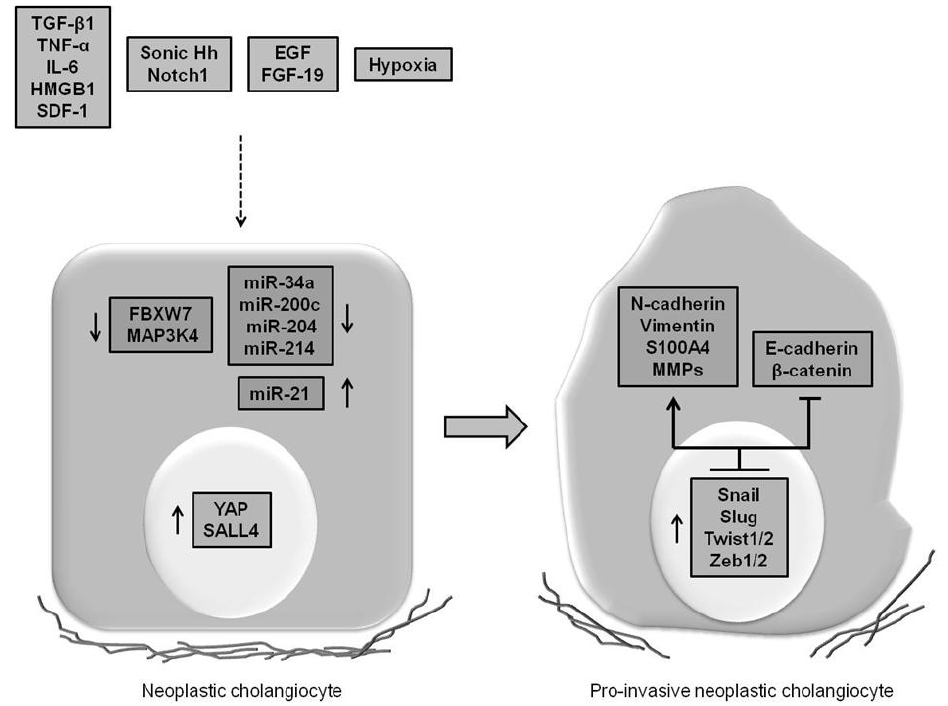
Figure 1. Autocrine and paracrine signals and intracellular stimuli orchestrate the switch towards a “transitional” phenotype during neoplastic transformation. The emergence of mesenchymal traits in CCA cells (up-regulation of N -cadherin, vimentin, S100A4 and metalloproteinases, along with down-regulation of E-cadherin and membranous β -catenin) is driven by a set of embryonic transcription factors (Snail, Slug, Twist1/2, and Zeb1/2), whose expression is induced by both soluble factors released in the tumor microenvironment (cyto/chemokines, growth factors, and morphogens) and mutational events affecting the activity of miRNAs, oncogenes, and tumor suppressor genes. These “transitional” changes allow cancer cells to reduce intercellular adhesion and dismantle the basement membrane, resulting in a motile phenotype. Transforming growth factor β 1, TGF- β 1; tumor necrosis factor α , TNF- α ; interleukin 6, IL-6; high-mobility group box 1, HMGB1; stromal cell-derived factor 1, SDF-1; epidermal growth factor, EGF; fibroblast growth factor 19, FGF-19; Hedgehog, Hh; F-box and WD repeat domain-containing 7, FBXW7; mitogen-activated protein 3 kinase 4,